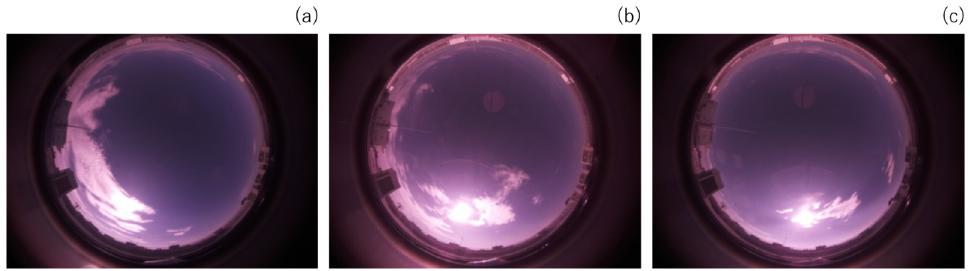
Figure 10. All-sky camera images at CHF around the time of EQ2: ( a ) 1.5 h before the EQ, ( b ) 30 min before the EQ, and ( c ) 30 min after the EQ.